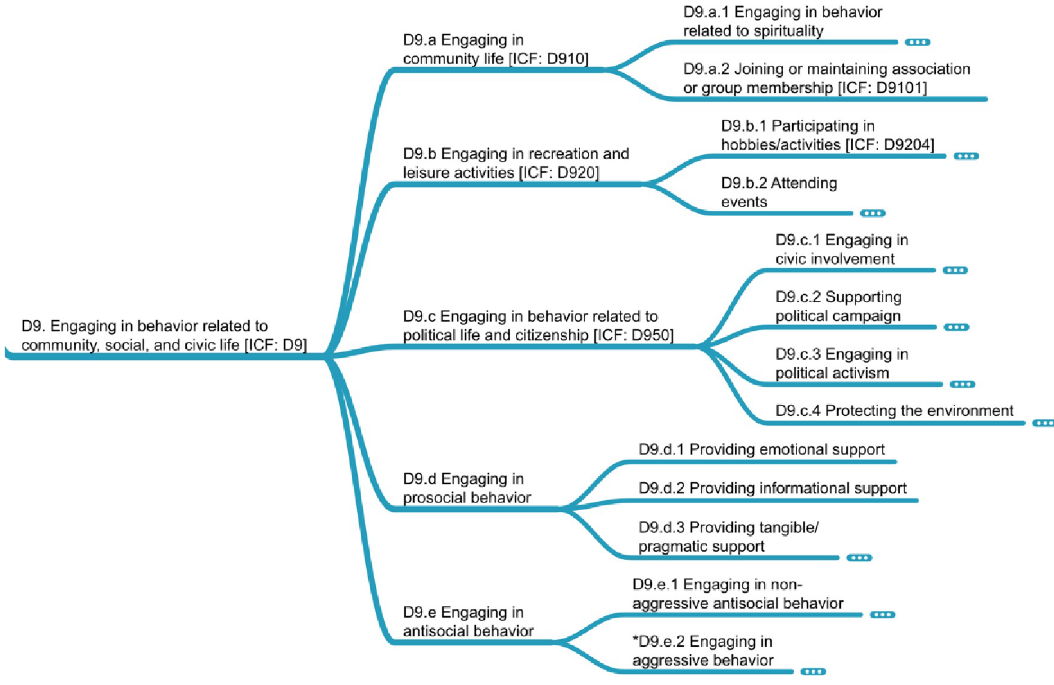
Fig 11. D9 domain on engaging in behavior related to community, social, and civic